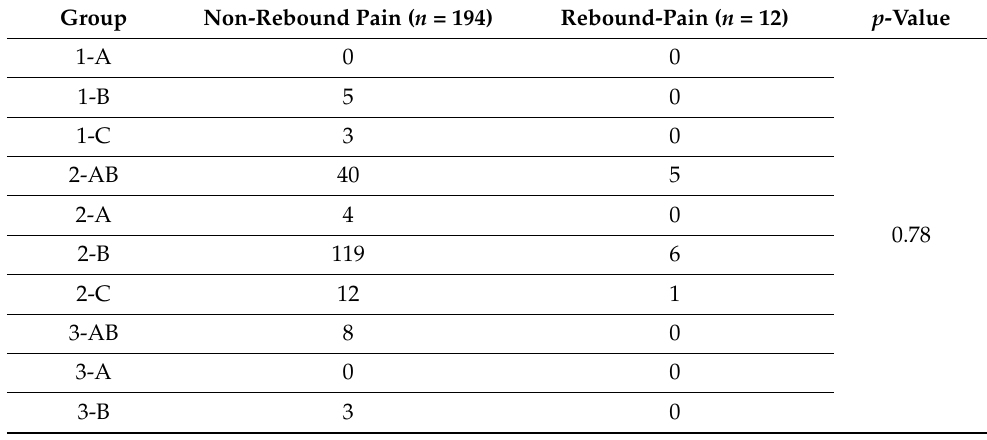
Table 5. The size and location of the herniated disc in the two groups (based on MSU classification). Group Non-Rebound Pain ( n = 194) Rebound-Pain ( n =